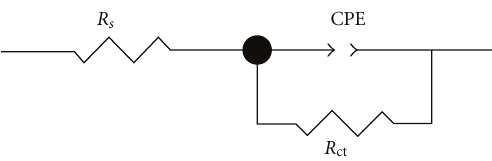
Figure 4: Electrochemical equivalent circuit used to fit the impedance